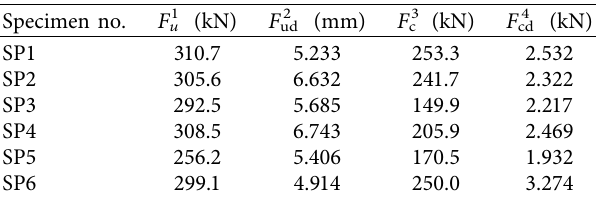
Table 5: Test results of